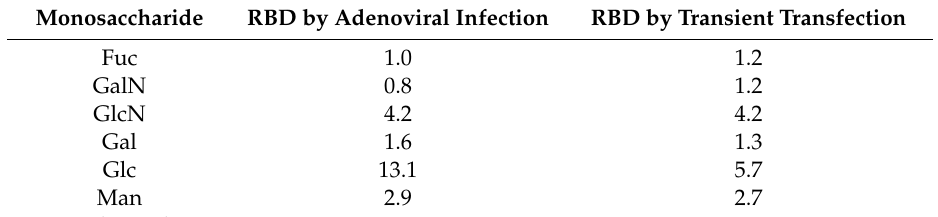
Table 5. Monosaccharide and sialic acid molecular ratio (Mol Monosaccharide / Mol RBD) after hydrolysis or enzymatic release for RBD produced via a viral and a non-viral transient expression vector in HEK293SF cells, cultured in suspension and serum-free media in 3L controlled bioreactors.